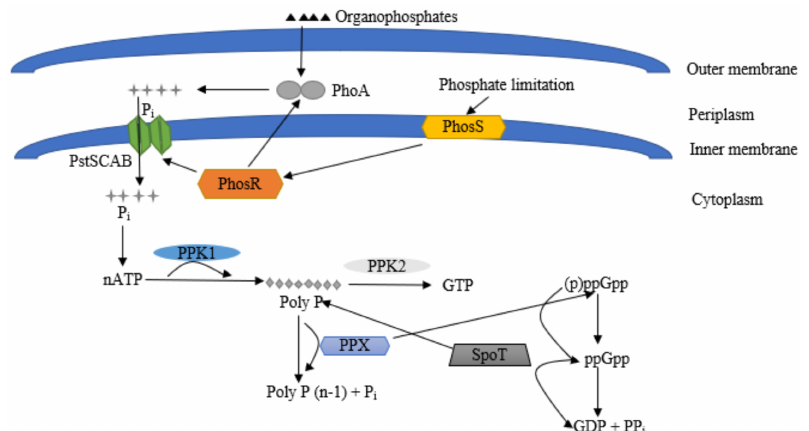
Figure 3. PhosS-PhosR two-component system. Organophosphates are hydrolysed to inorganic phosphate (P i ) by alkaline phosphatase (PhoA) in the periplasm. Phosphate uptake proteins and PhoA are directly regulated by the PhosS-PhosR TCS which is activated by phosphate limitation. P i is transported across the inner membrane via the high-affinity phosphate transport system PstSCAB. ATP generated from Pi is utilised for polyP synthesis by PPK1. PPK2 utilises polyP to generate GTP, while PPX hydrolyses poly P back to Pi. PPX also affects the conversion of (p)ppGpp to ppGpp. SpoT is a bifunctional enzyme involved in both ppGpp synthesis and its hydrolysis. SpoT is also linked to poly P metabolism. This figure was adapted from Kumar et al.